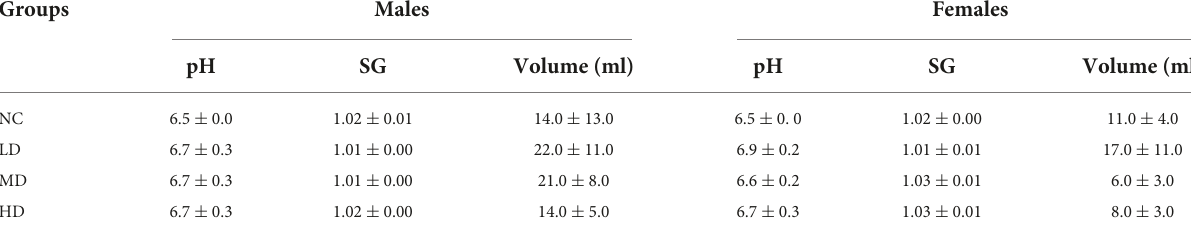
TABLE 4 Effects of aqueous extracts of Cyclocarya paliurus leaves on the urinalysis parameters of Sprague-Dawley (SD) rats in the acute toxicity study. Groups Males Females pH SG Volume (ml) pH SG Volume